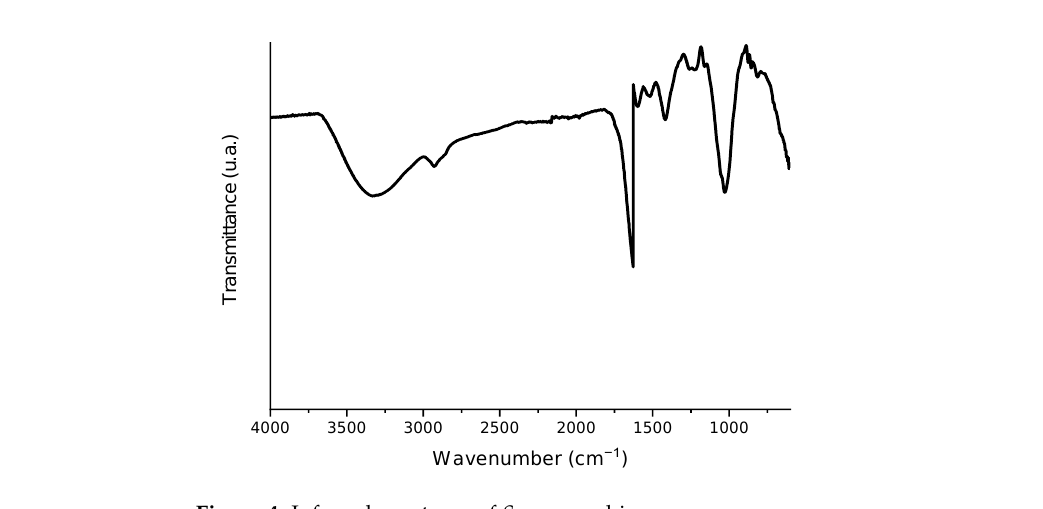
Figure 4. Infrared spectrum of Sargassum biomass. Table 4. Main assignments of the FT-IR spectrum of Sargassum .